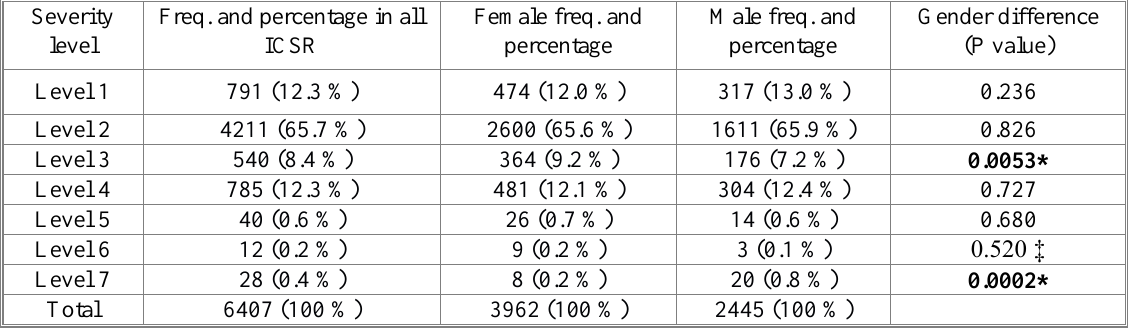
Table 7. Severity of ADR in both gender